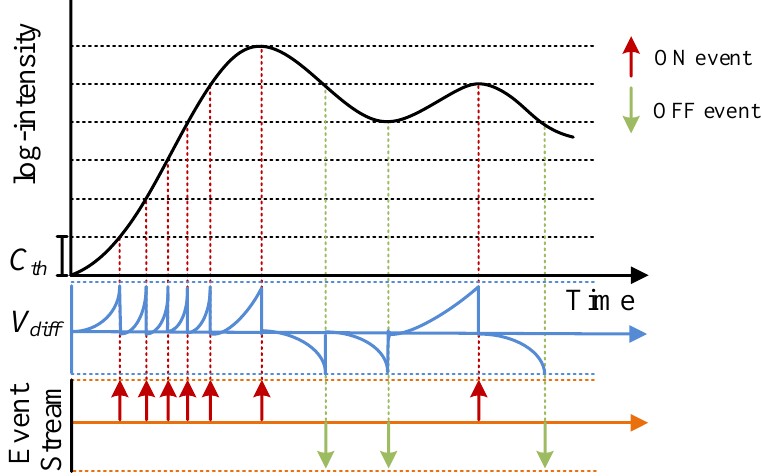
(cid:12) (cid:12) (cid:12) (cid:12) > C th , an (cid:12) V dif f (cid:12)